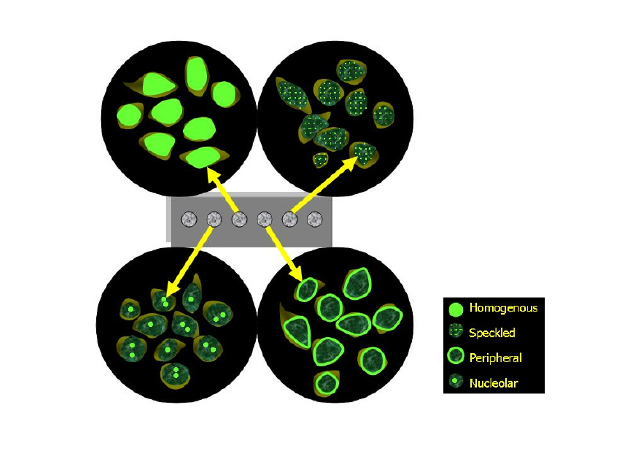
Figure 1 Diagrammatic representation of common nuclear patterns observed under fluorescence microscopy